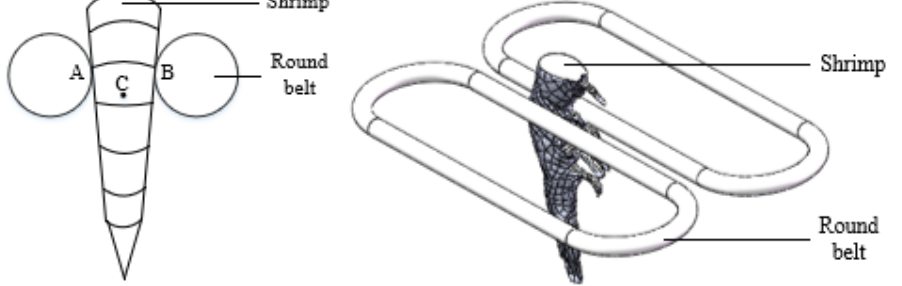
Figure 1. Symmetrically supported head-to-tail orientation: A is the left support point; B is the right support point; and C is the center of gravity of shrimp.